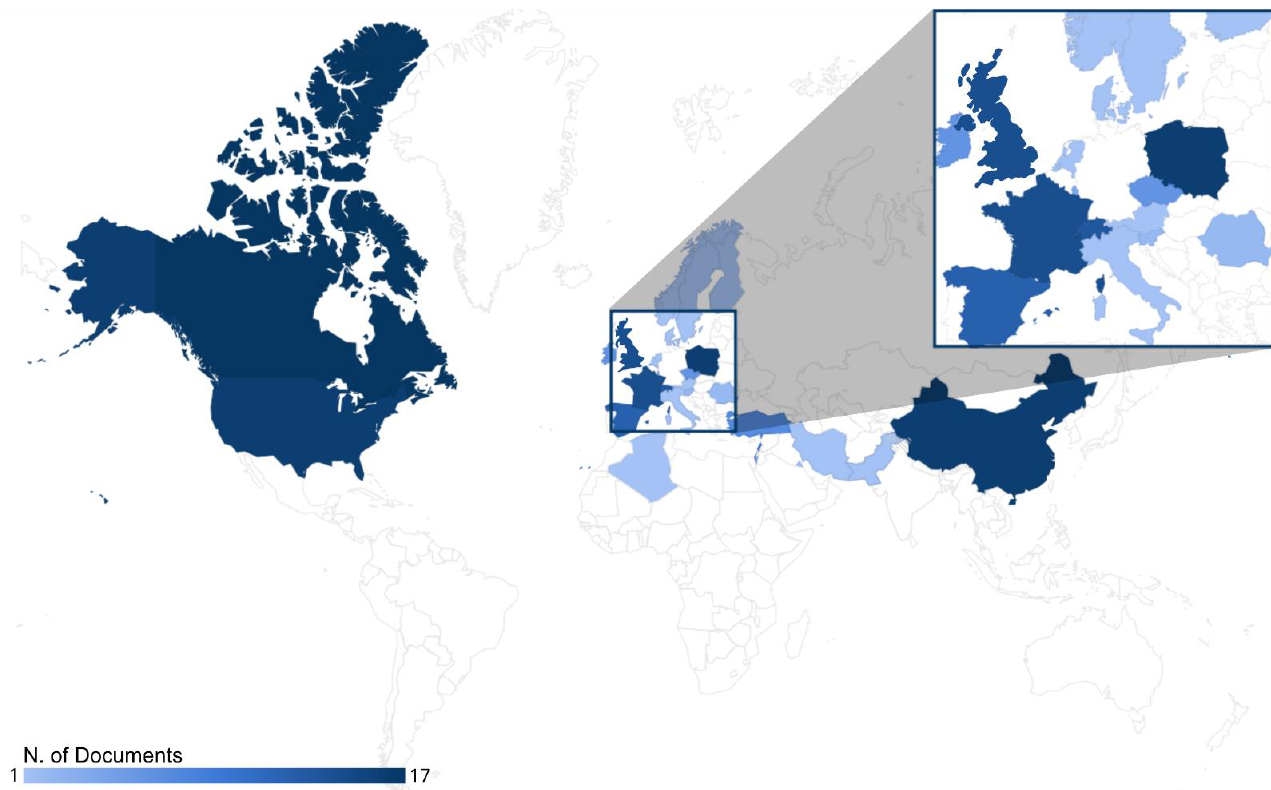
Figure 5. Global geographic distributions of publications in greywater energy recovery domain during the period from 2001 to 2022.